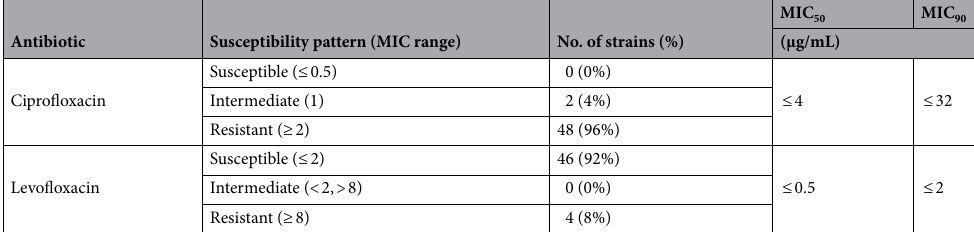
Table 1. Minimum inhibitory concentration ranges and susceptibility pattern of Stenotrophomonas maltophilia strains against ciprofloxacin and levofloxacin. Since the critical concentrations of ciprofloxacin for Stenotrophomonas maltophilia are not defined by the CLSI, the critical concentrations of Pseudomonas aeruginosa have been used to interpret the results of ciprofloxacin susceptibility 35 . MIC minimum inhibitory